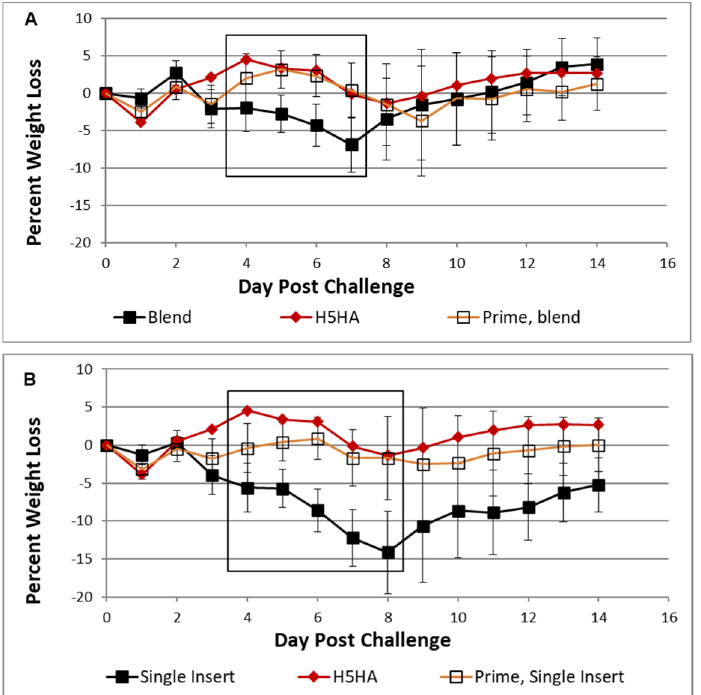
Figure 4. Based upon body weight of BALB/c mice after H5N1 challenge, non-HA antigen vaccines can build upon immunity conferred previously by natural heterologous infection (empty squares), reaching the level of weight loss protection provided by H5 HA (solid red diamonds) delivered two times. Mice in groups of eight were immunized two times using MVA vaccines (solid symbols) or after natural INFV exposure (“Prime”, empty symbols) using low dose non-lethal PR8 INFV A. After H5N1 lethal challenge, mice were monitored for daily body weight and survival for 14 days. The period of 4 to 7–8 days post challenge is framed in each panel to illustrate absence of weight loss due to natural INFV exposure. Heterologous exposure to native PR8 H1N1 INFV A, followed by administration of NP + METRC + M1 expressed as a single insert in MVA (( A) , empty squares, “Prime, single insert”) or as a blended vaccine of individually expressed antigens in MVA (( B ), empty squares, “prime, blend”) conferred minor weight loss similar to homologous HA vaccine.